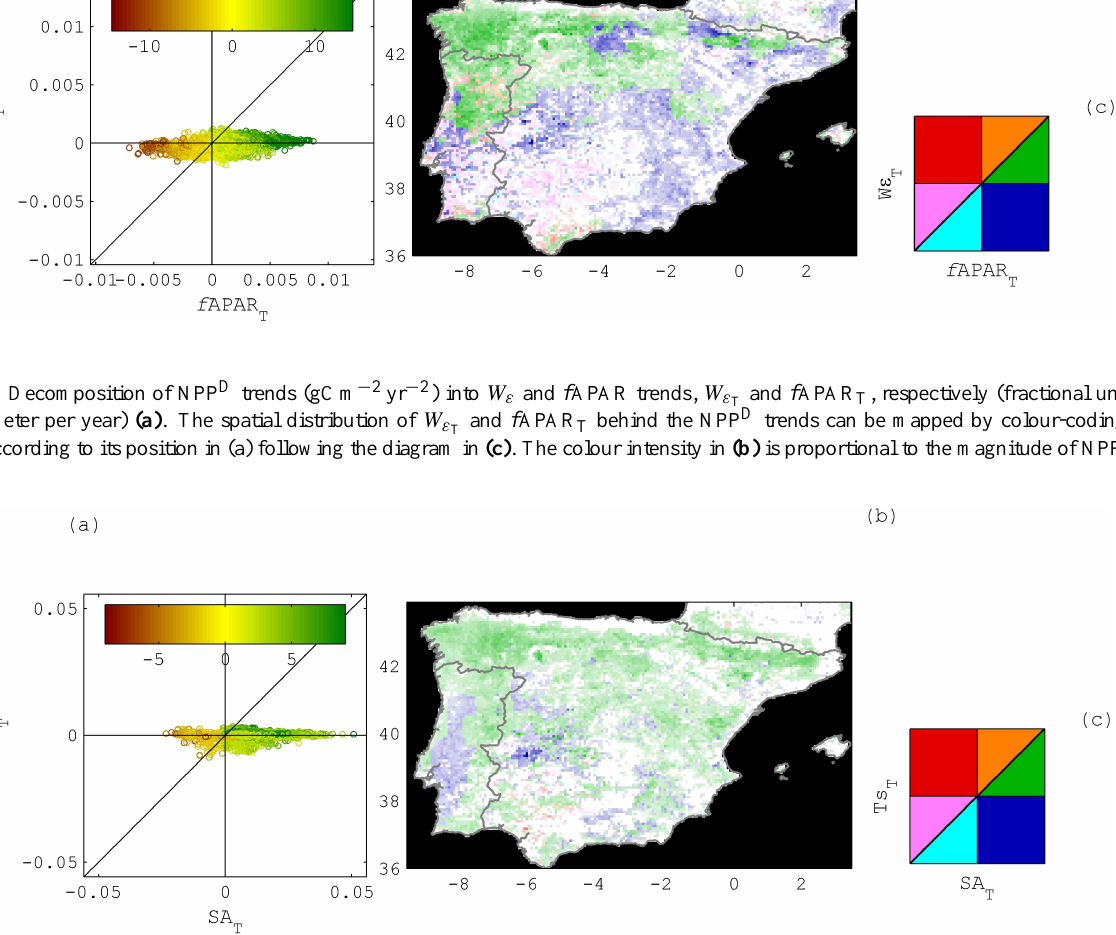
Fig. 12. Decomposition of R D trends (gCm − 2 yr − 2 ) into T s and substrate availability trends, T s H distribution of T s and SA T behind the R D trends can be mapped by colour-coding each RH D H T diagram in (c) . The colour intensity in (b) is proportional to the magnitude of RH D